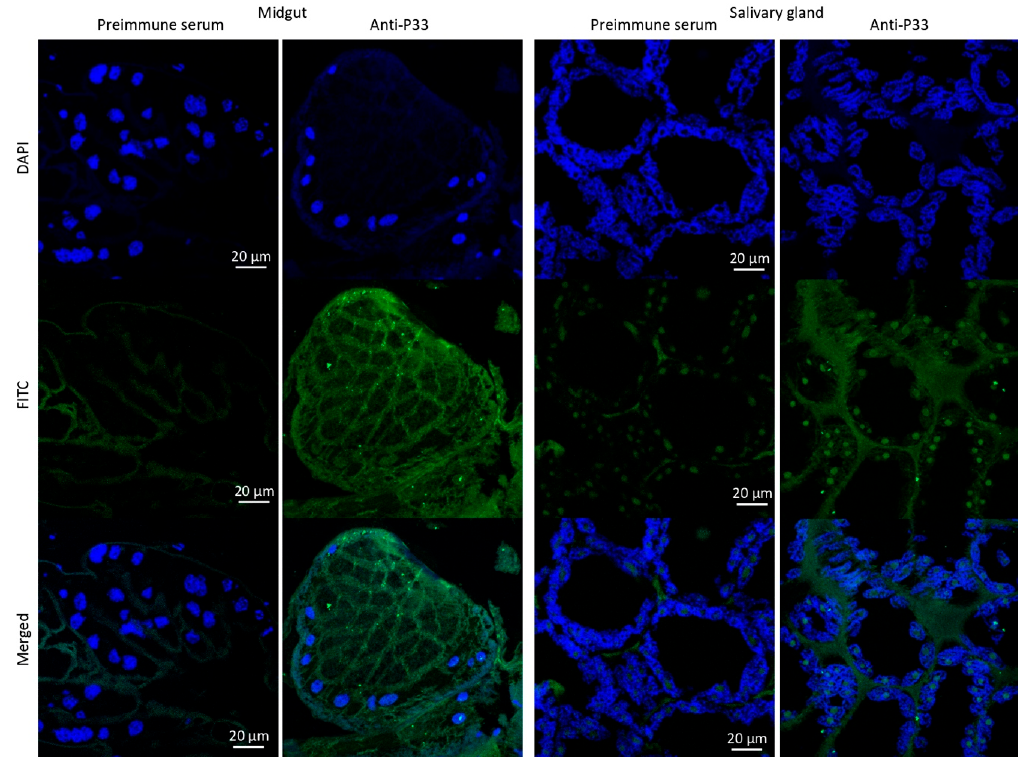
Figure 3. Localization of P33 in salmon louse midgut and salivary glands. The green channel is P33 stained with goat anti-rabbit IgG-FITC antibodies, and the blue channel is DAPI-stained DNA (nucleus). Merged combine images of green and blue channels. There was no specific labeling of P33 in negative control sections treated with preimmune serum. Scale bar: 20 μ m.